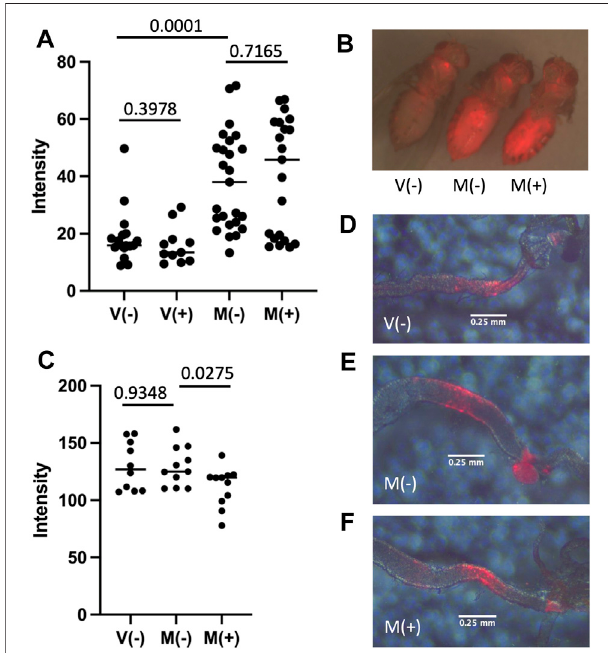
FIGURE 6 | Effect of mifepristone on SREBP reporter activity. Flies are the progeny of cross SREBP-R x UAS-mCherry . Virgin females (V) and mated females (M) were maintained for 12 days in the absence ( − ) or presence (+) of 200 μ g/ml mifepristone, as indicated. (A , B) Florescence intensity of the abdomen was quanti fi ed using red fl uorescence image capture and ImageJ. (A) Abdominal fl uorescence quanti fi cation. (B) Representative fl ies. Image presented is overlay of red fl uorescence image and visible light images. (C) Posterior midgut fl uorescence quanti fi cation. Midgut tissue was dissected, mounted on slides, and fl orescence intensity of the posterior midgut was quanti fi ed using red fl uorescence image capture and ImageJ. (D – F) Representative posterior midguts. Image presented is overlay of red fl uorescence image and visible light images. Errors bars are placed below the region of the posterior midgut where the SREBP reporter activates expression of mCherry. (D) V( − ). (E) M( − ). (F)